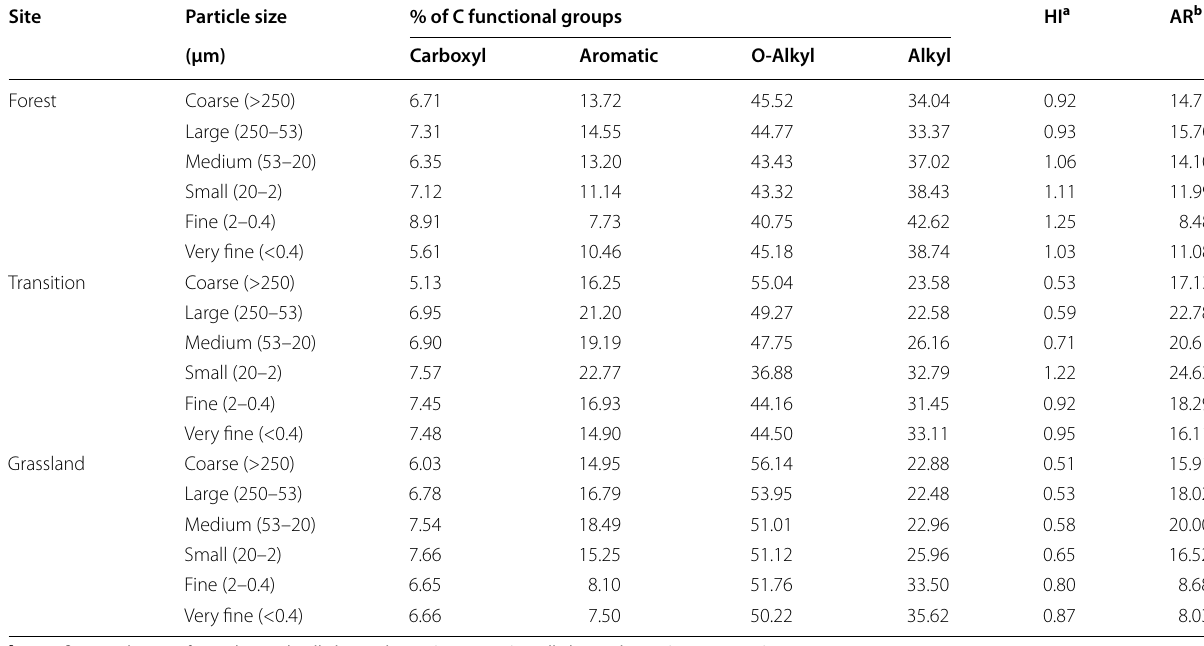
Table 5 Relative intensities of CP/MAS 13 C NMR spectra in different particle-size fractions in different sampling